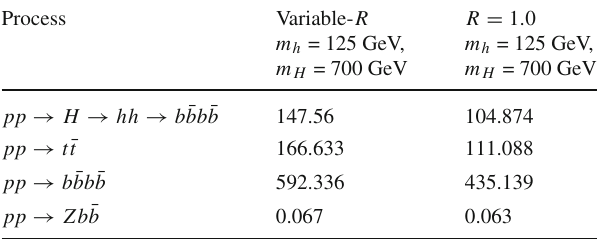
Table 2 Event rates of signal and backgrounds for L = 140 fb − 1 upon enforcing the initial cuts plus the mass selection criteria of Fig. 8 for the two jet reconstruction procedures